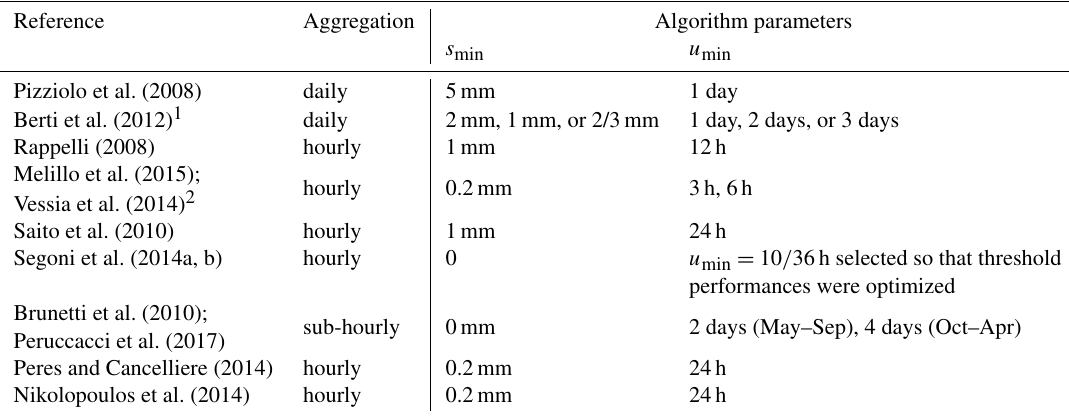
Table 3. Some rainfall event identification algorithms found in the literature.